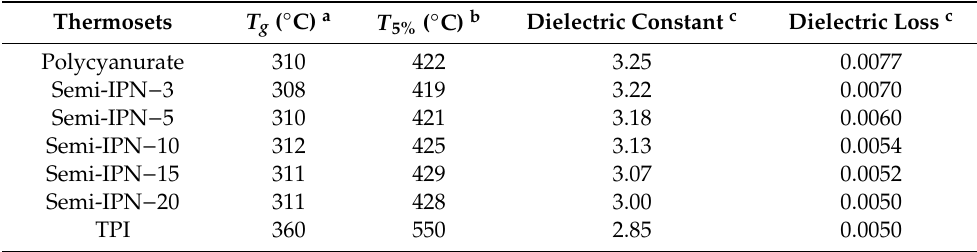
Table 2. Thermal and dielectric properties of polycyanurate, TPI, and semi-IPNs.